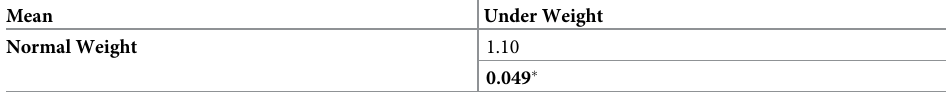
Table 9. Comparisons of total protein with categorized BMI using post hoc tests